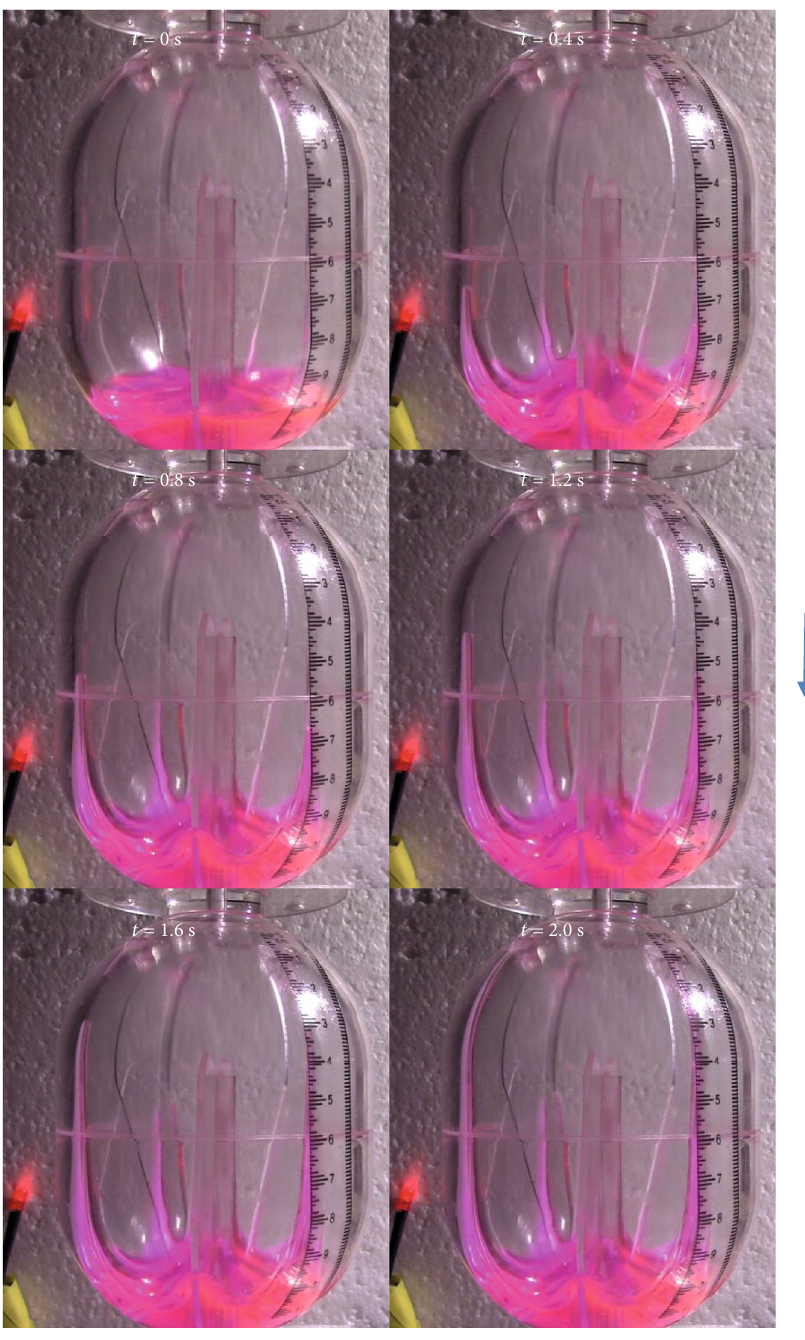
Figure 6: Liquid volume fraction is